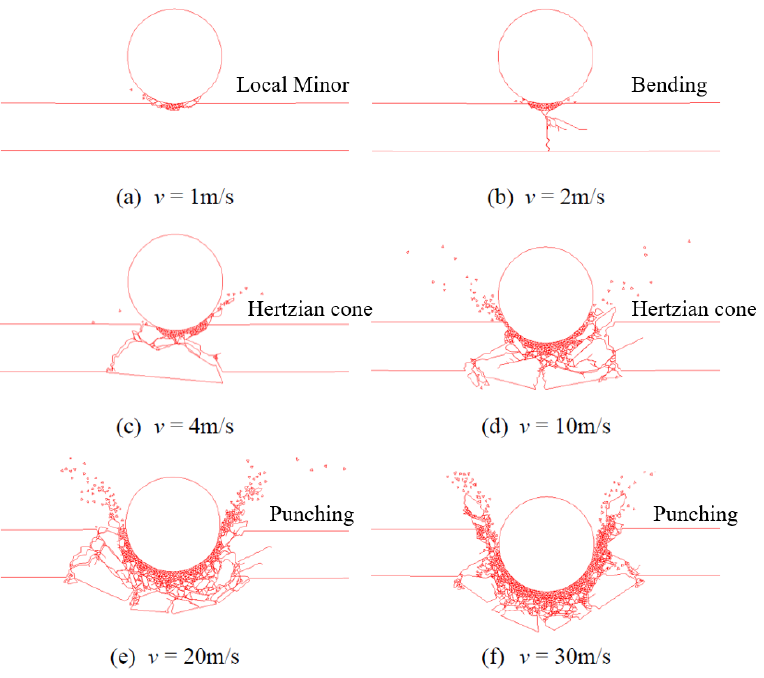
Figure 14. Damage patterns of the glass beam with different impact velocities at t = 1 ms.